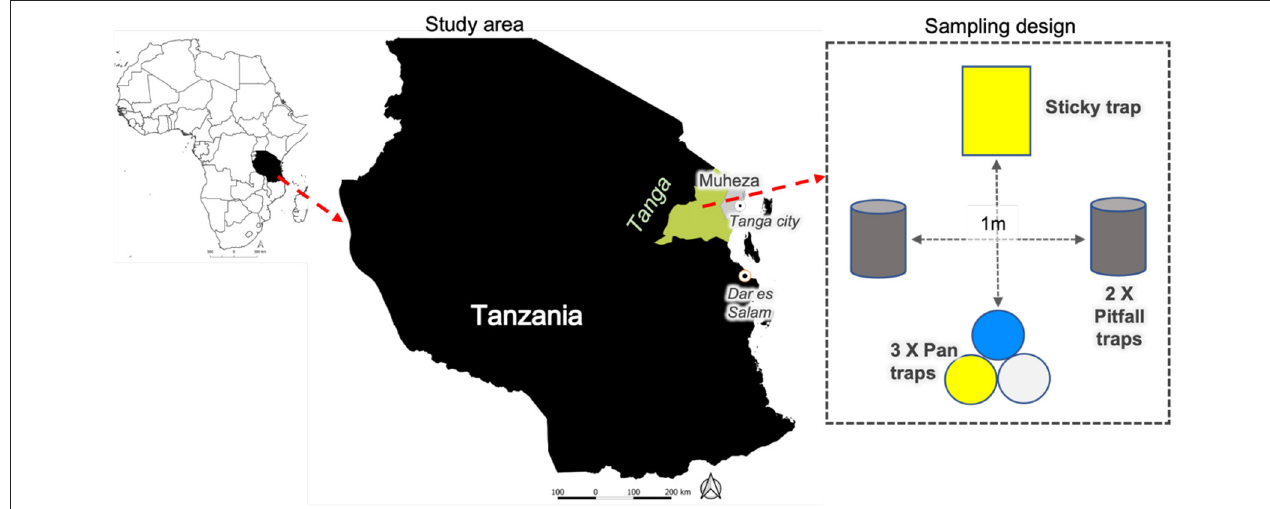
FIGURE 1 | Map of the study site and sampling design in Tanzania: East Usambara Mountains in Muheza District of Tanga Region. The traps were placed in the center and margin of 82 focal fields in the study area, with sampling taking place five times between Sept. 2019 and May 2020.